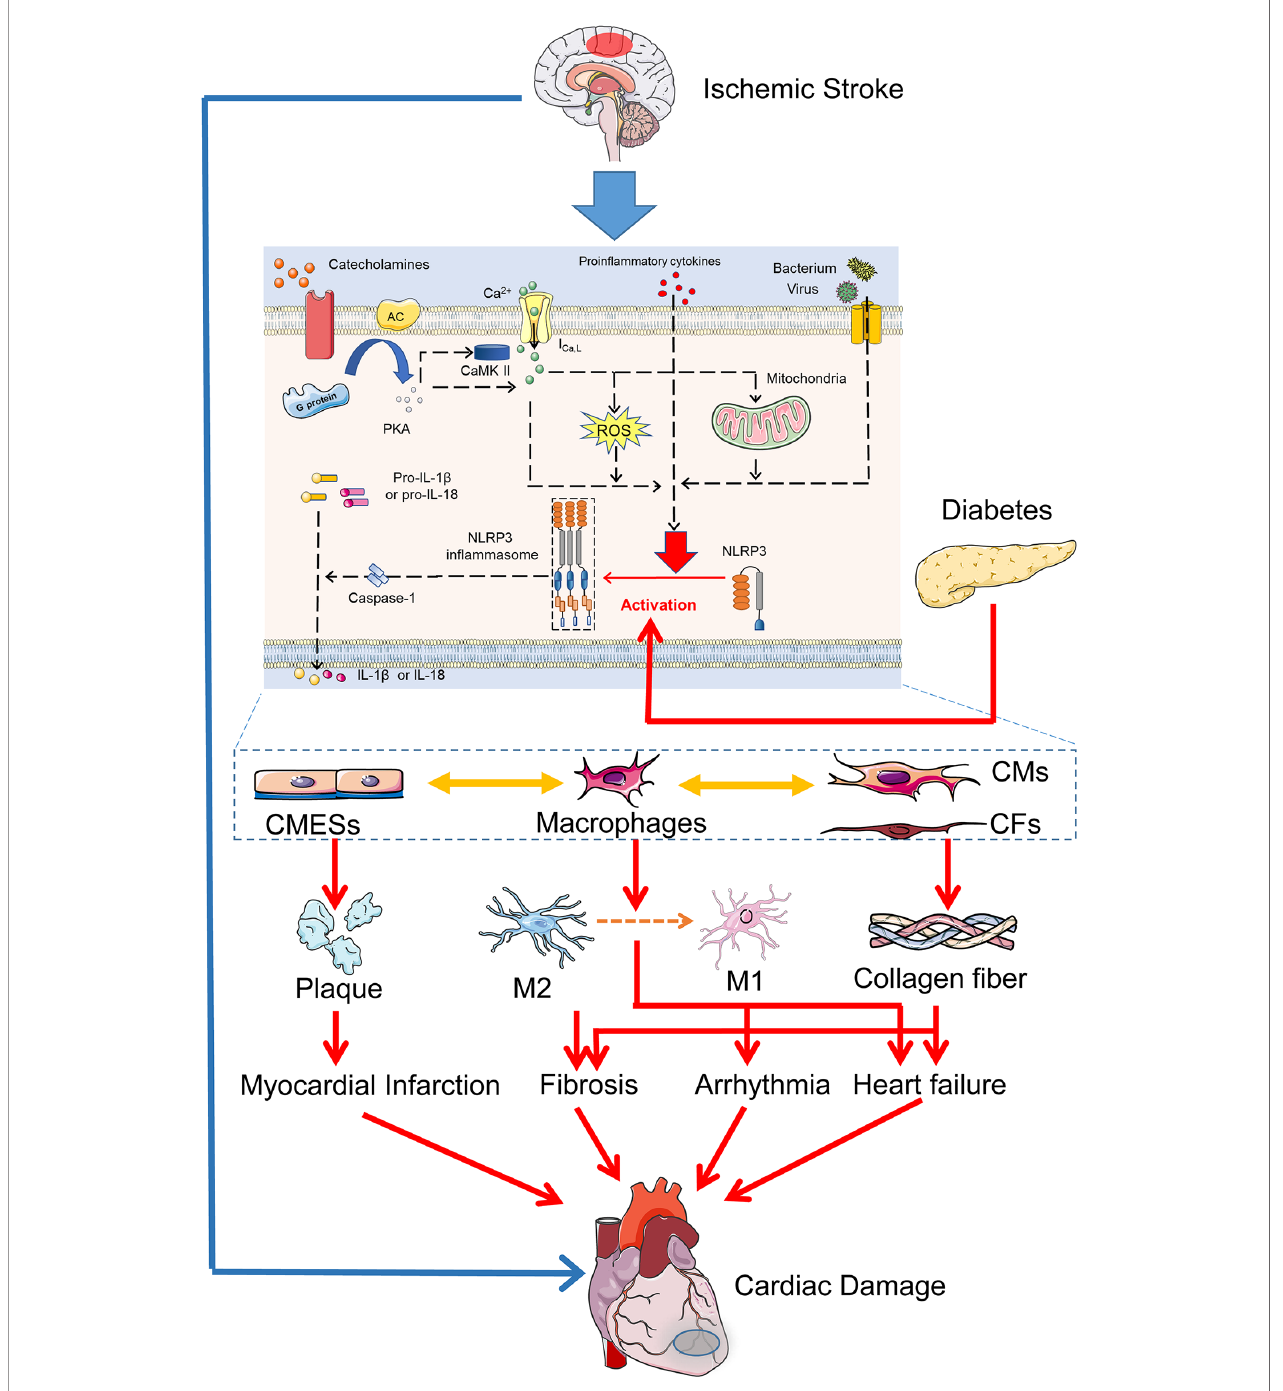
FIGURE 3 | NLRP3 in fl ammasome activation in diabetic cerebral-cardiac syndrome. Increased catecholamines, proin fl ammatory cytokines, and bacteria after IS induce intracellular Ca 2+ overload, mitochondrial dysfunction, ROS production, and activation of CaMKII in cardiac cells. These activators and hyperglycemia in diabetes directly activate the NLRP3 in fl ammasome in various cardiac cell types. NLRP3 in fl ammasome activation in CMESs induces platelet and macrophage aggregation. In cardiac macrophages, NLRP3 in fl ammasome activation promotes M1 macrophage polarization and provokes the cardiac in fl ammation damage. In CMs and CFs, NLRP3 in fl ammasome activation increases the expression of pro fi brotic genes and promotes myocardial fi brosis. Overall, IS and diabetes coactivate NLRP3 in fl ammasome in various cardiac cells, which ultimately leads to arrhythmia, myocardial fi brosis, myocardial infarction, and heart failure, resulting in diverse cardiac damage. CMESs, cardiac microvascular endothelial cells; CMs, cardiomyocytes; CFs, cardiac fi